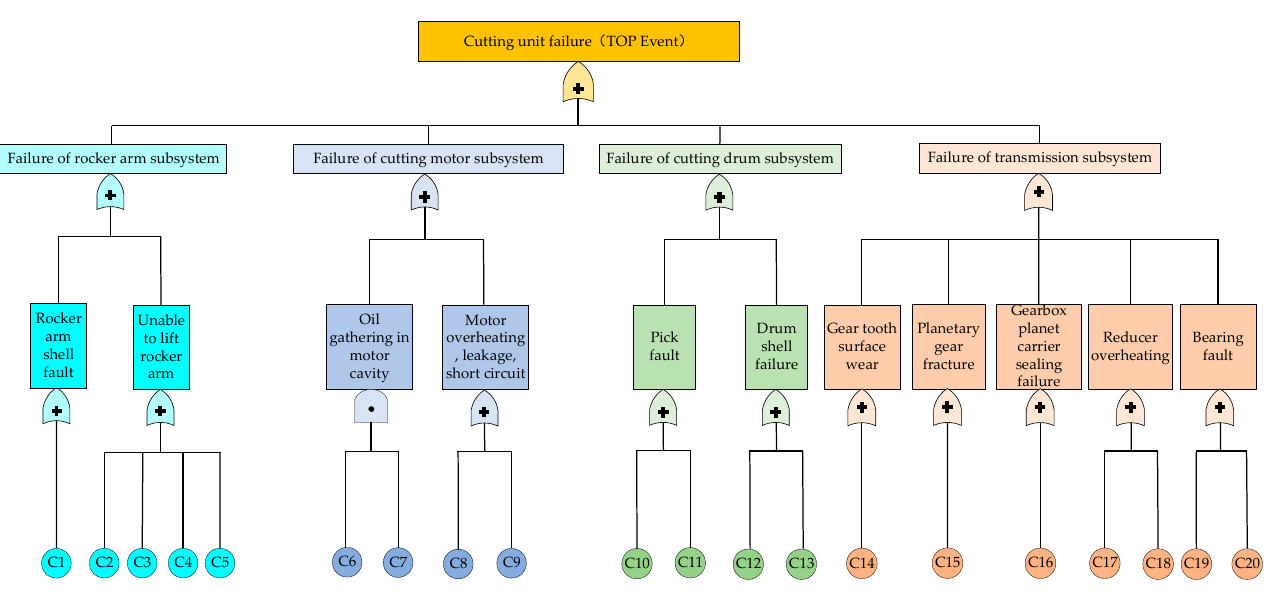
Figure 4. Fault tree model of shearer-cutting units.